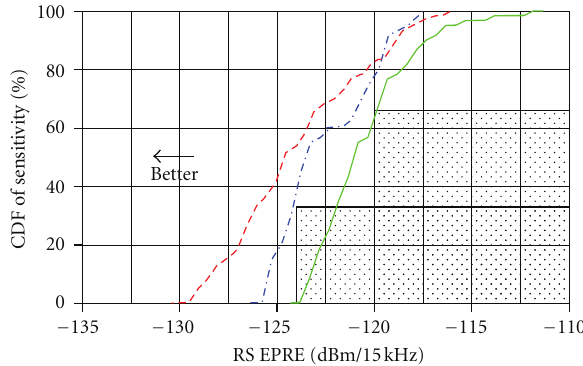
Figure 4: Measured CDF of sensitivity for three di ff erent com- mercially available LTE devices. Shaded regions illustrate potential rejection criteria (see text).